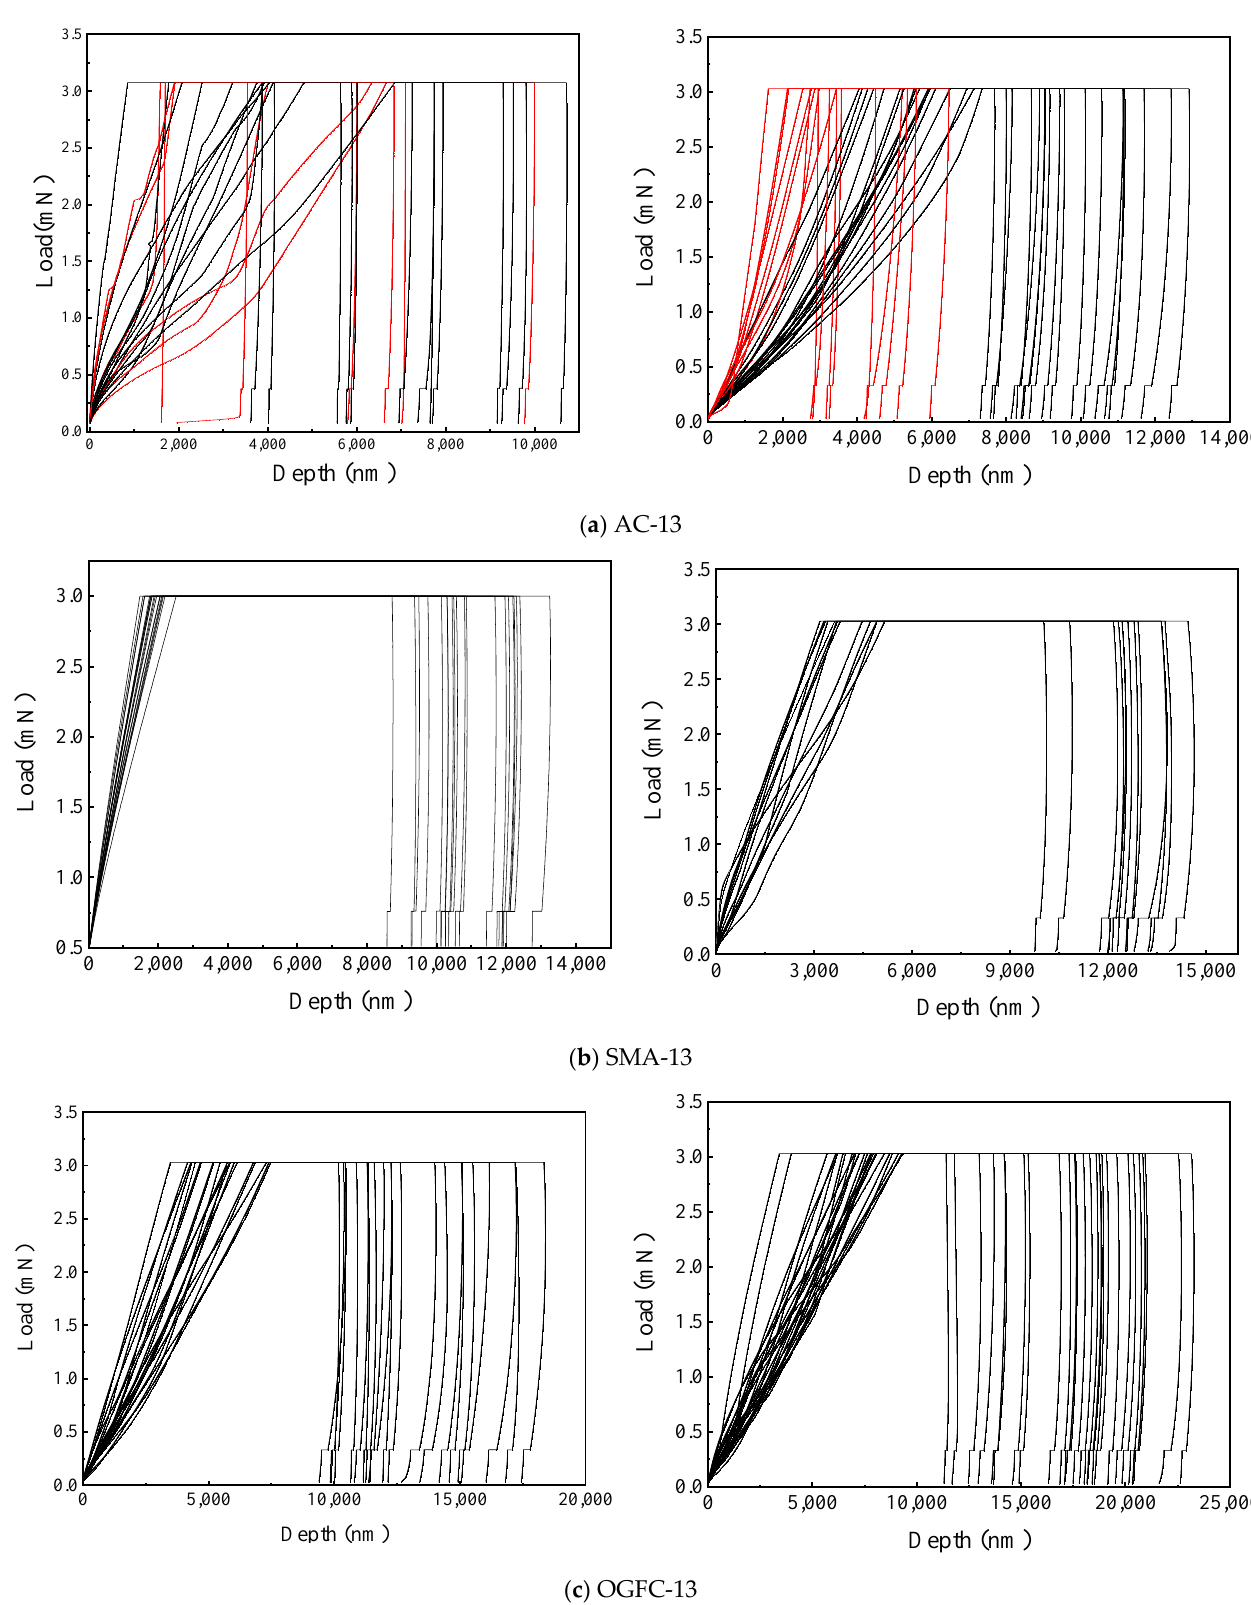
Figure 7. Nanoindentation load – depth curves of asphalt mixture with different gradations.